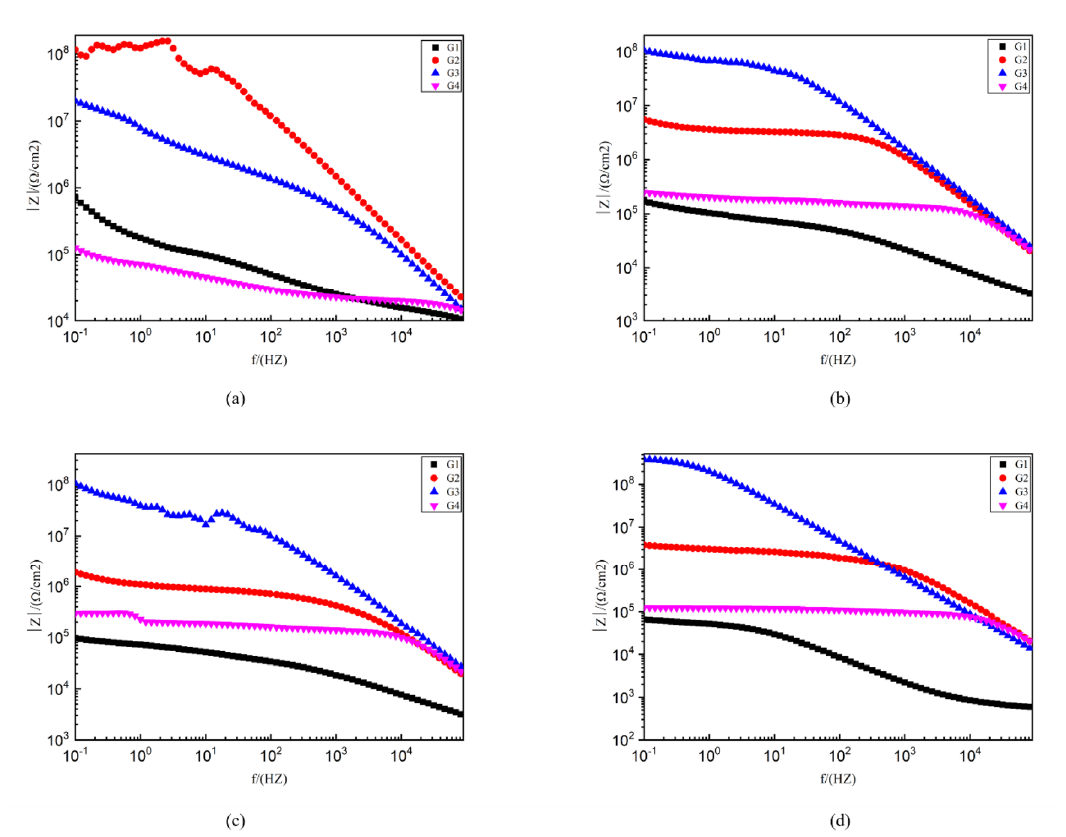
Figure 10. Each EP/CeO 2 -GO coating’s Bode pattern for immersion for 2 d, 8 d, 16 d and 24 d, respectively: ( a ) Bode pattern for 2 d; ( b ) Bode pattern for 8 d; ( c ) Bode pattern for 16 d; ( d ) Bode pattern for 24 d.